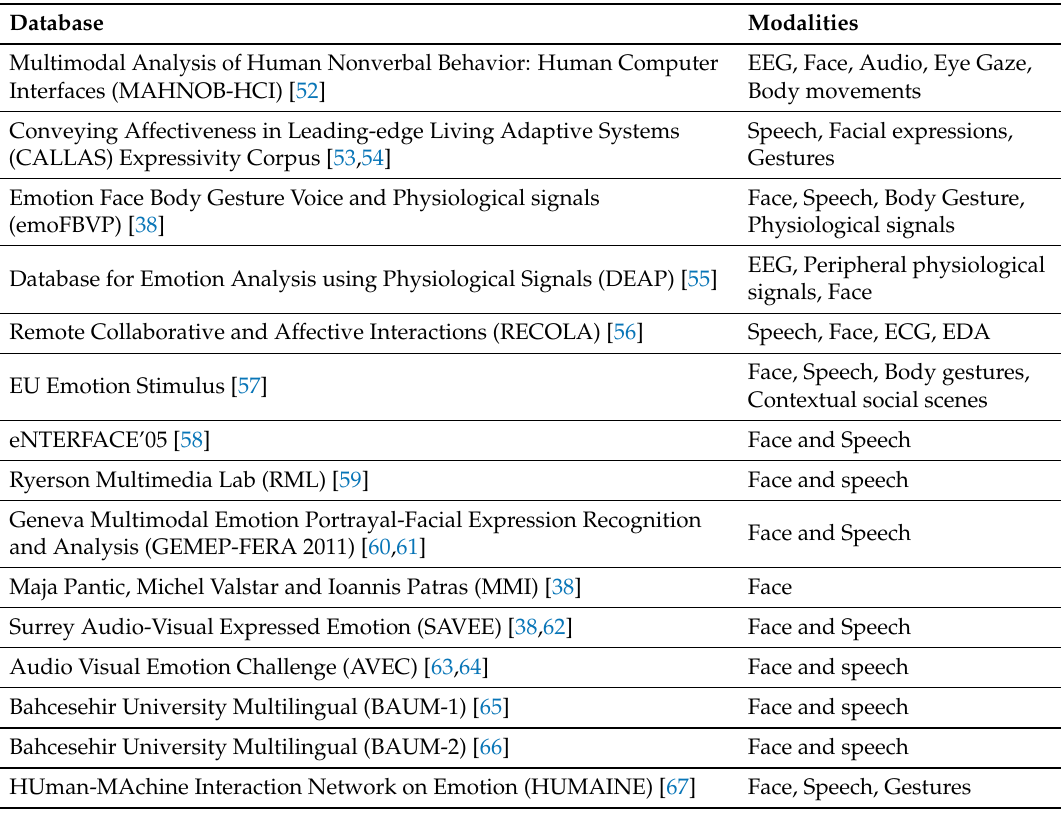
Table 1. Multimodal emotional